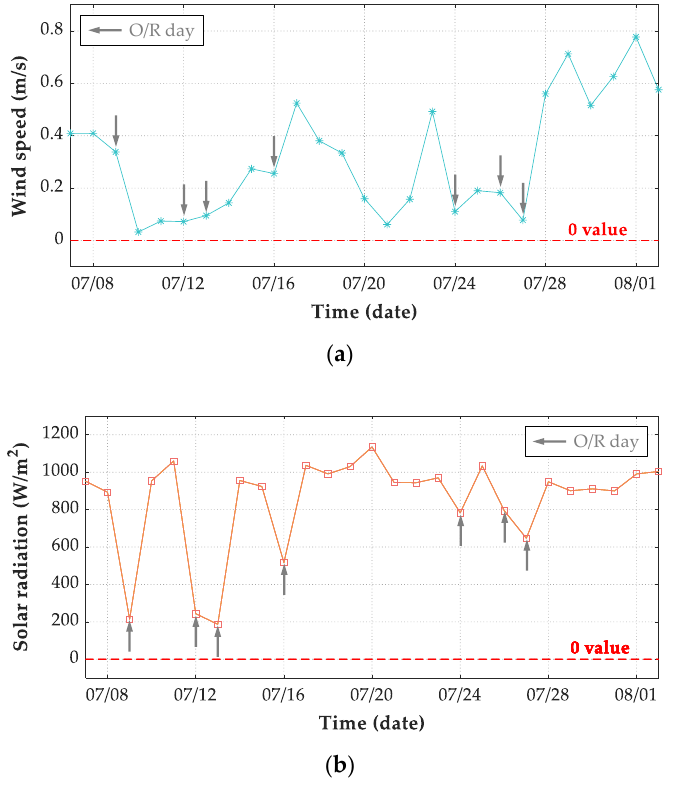
Figure 15. Daily environmental records from 7 July 2019 to 2 August 2019. ( a ) Average wind speed; ( b ) maximum solar radiation every 10 minutes.